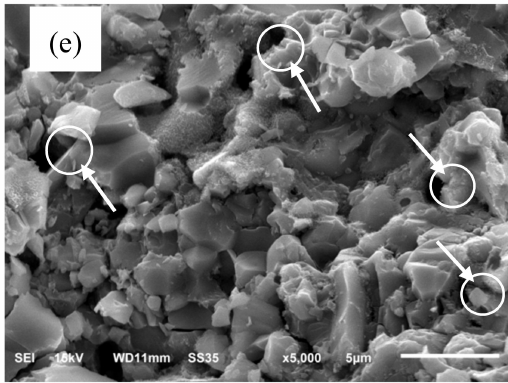
Figure 4. SEM images of the SiC-AlN ceramics with different SiC contents: ( a ) 40 wt. %; ( b ) 45 wt. %; ( c ) 50 wt. %; ( d ) 55 wt. %; ( e ) 60 wt. %. Circles and arrows mark the pore